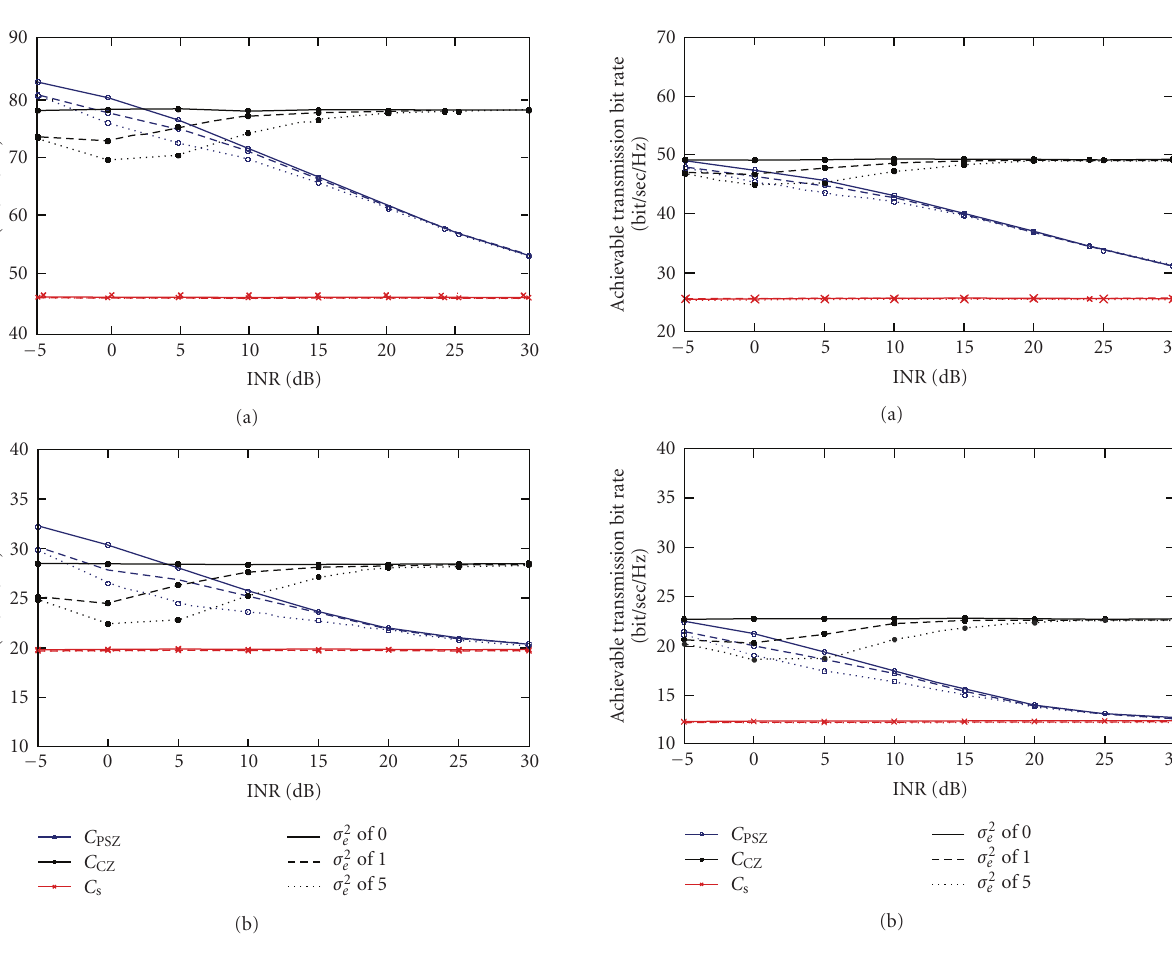
Figure 5: Median value of achievable transmission bit rate versus INR for 8 × 4 MIMO systems (a) when SNR is 30dB and (b) when SNR is 10dB.